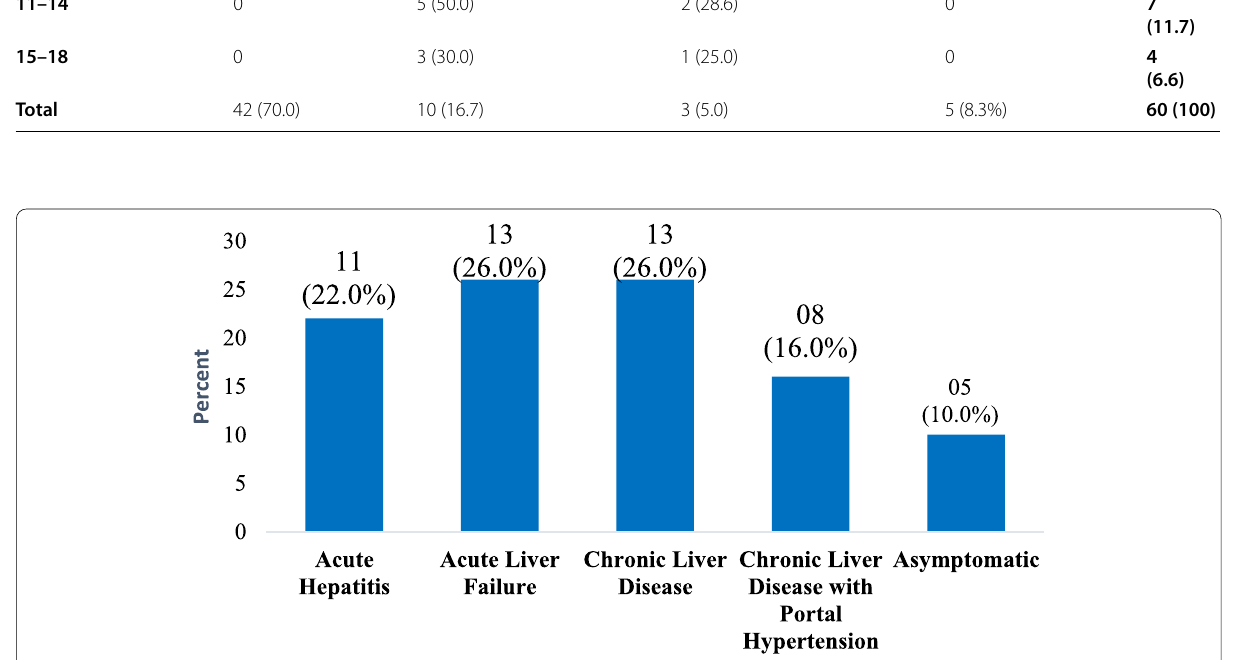
Fig. 2 Different types of hepatic presentation in the studied children ( n